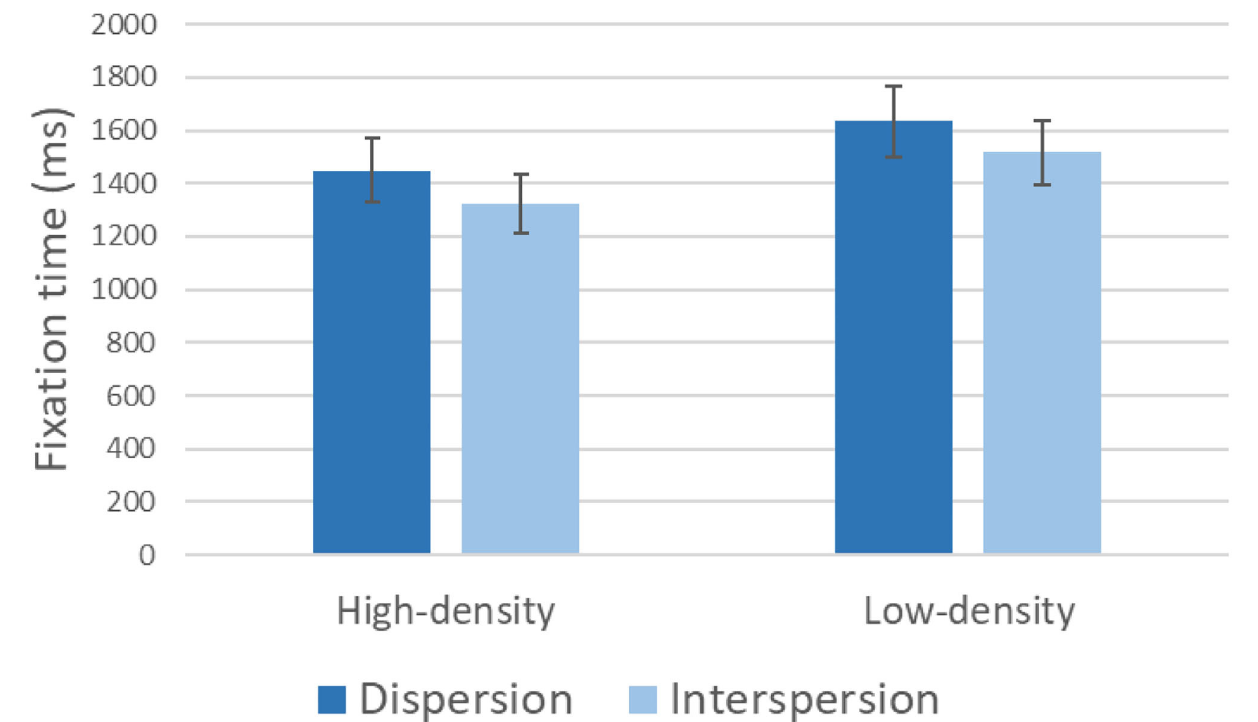
FIGURE 6 | Cumulative fixation time as a function of aggregation level and aggregation